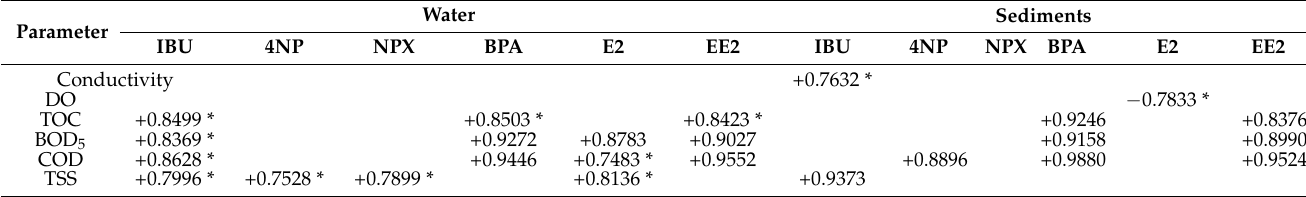
Table 7. Correlations observed between the compounds detected in water and sediment with physicochemical